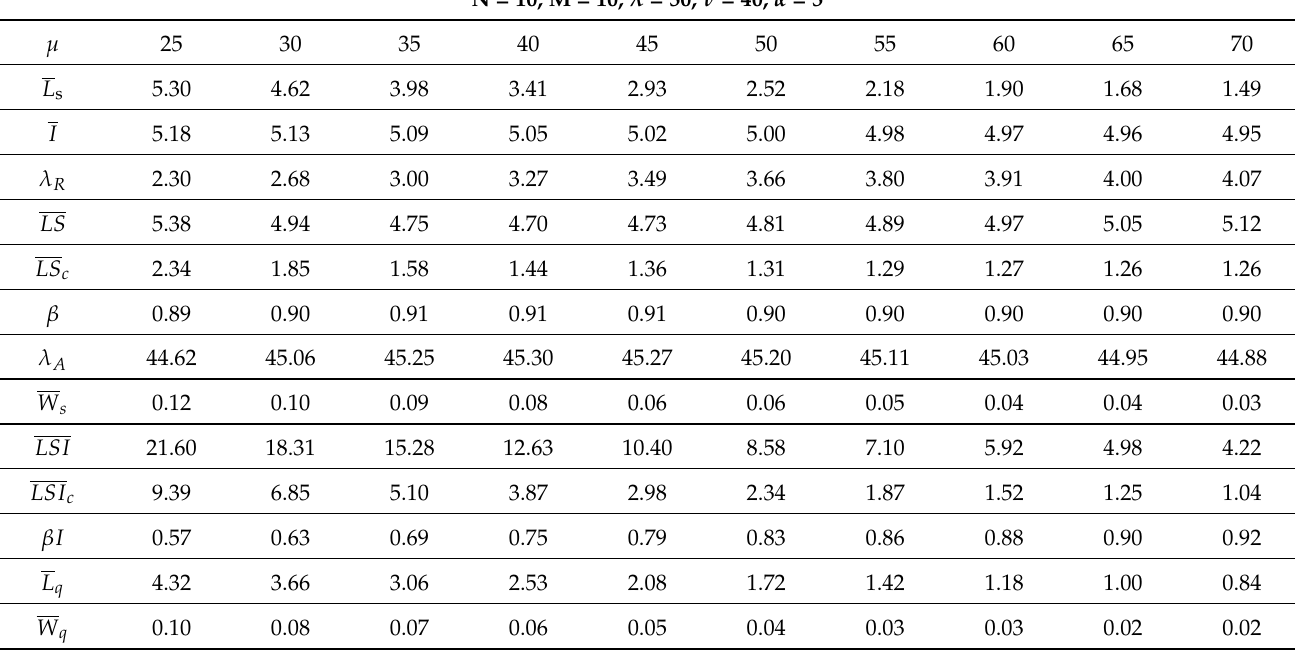
Table 2. The effect of changing the speed of the service on the performance measure when the maximal capacity of the system and the maximal capacity of the inventory is 10 with impatient customers under a deterministic order